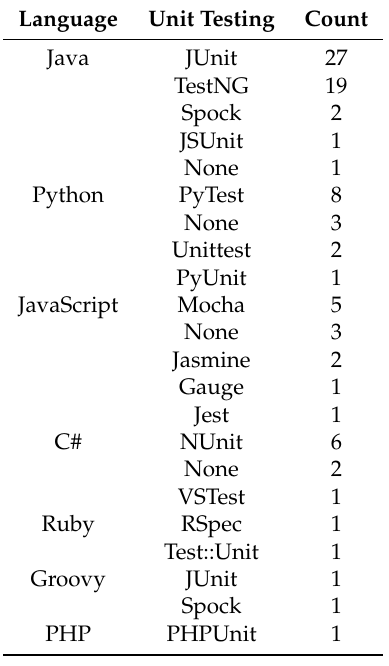
Table A13. 5.a. Which unit testing framework do you use in conjunction with Selenium?